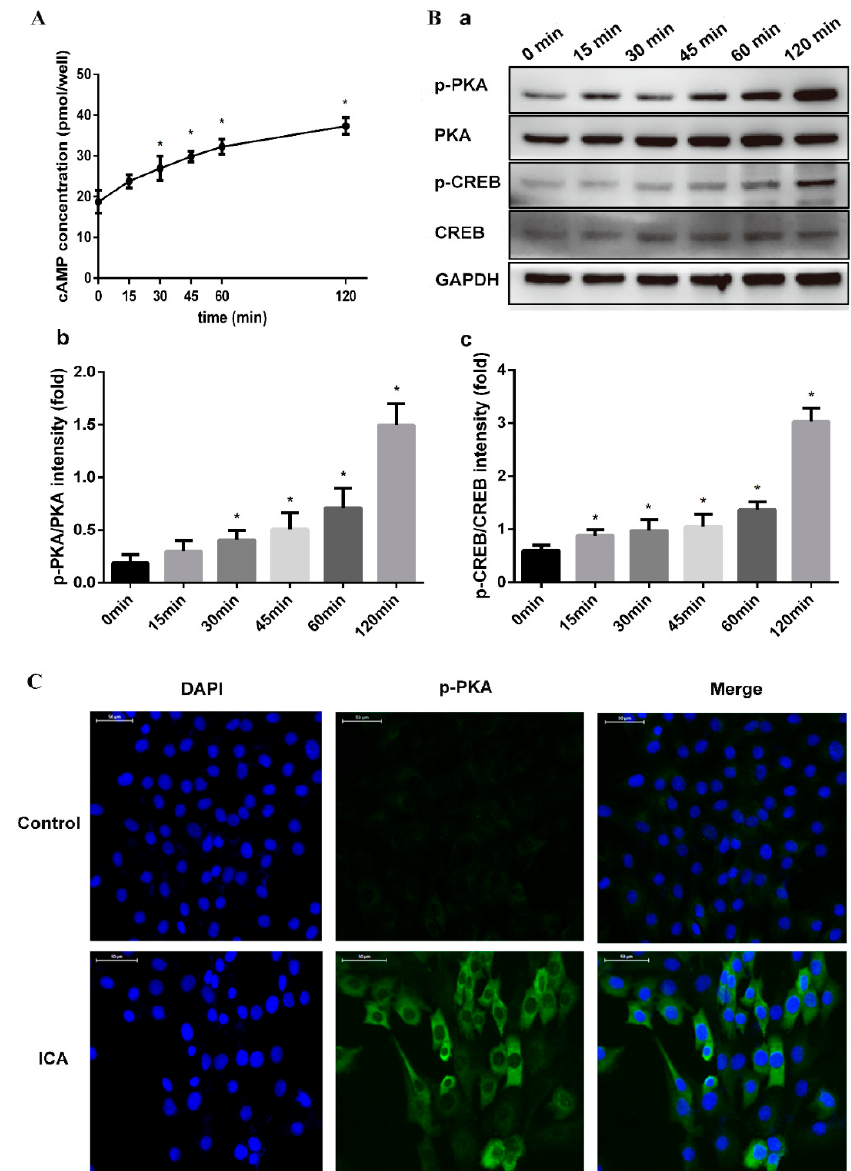
Figure 5. ICA activated the cAMP / PKA / CREB pathway in promoting bone formation. The changes of intracellular cAMP level ( A ) and the protein expression levels of phosphorylated PKA (p-PKA), phosphorylated CREB (p-CREB), total PKA, and CREB ( B-a ) after C2C12 exposure for 0, 15, 30, 45, 60 and 120 min. ( B-b ) Relative density of p-PKA expression levels. ( B-c ) Relative density of p-CREB expression levels. ( C ) The expression of p-PKA after 120 min of ICA treatment by immunofluorescence assays. p-PKA was stained green, and nuclei were stained blue (with DAPI). Bar represents the mean ± SD ( n = 3). * p < 0.05.